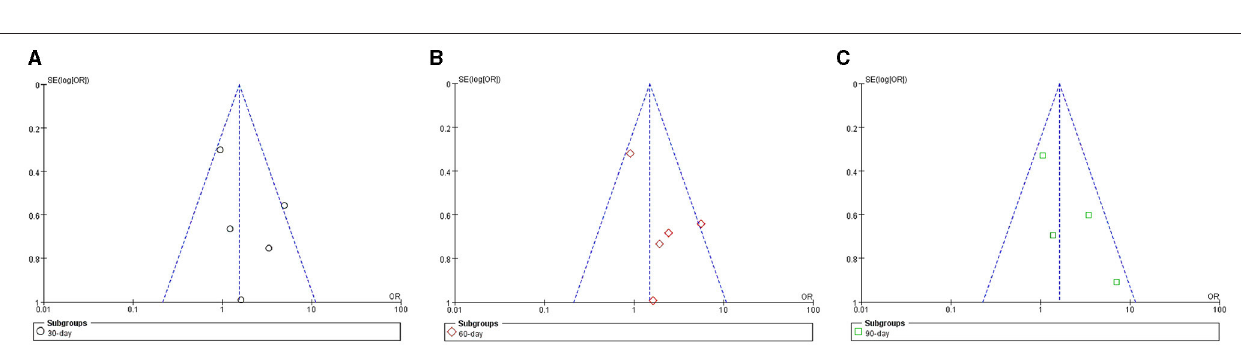
FIGURE 9 | Funnel plot of meta-analyses for survival rate in ACLF patients. (A) 30-day; (B) 60-day; (C)